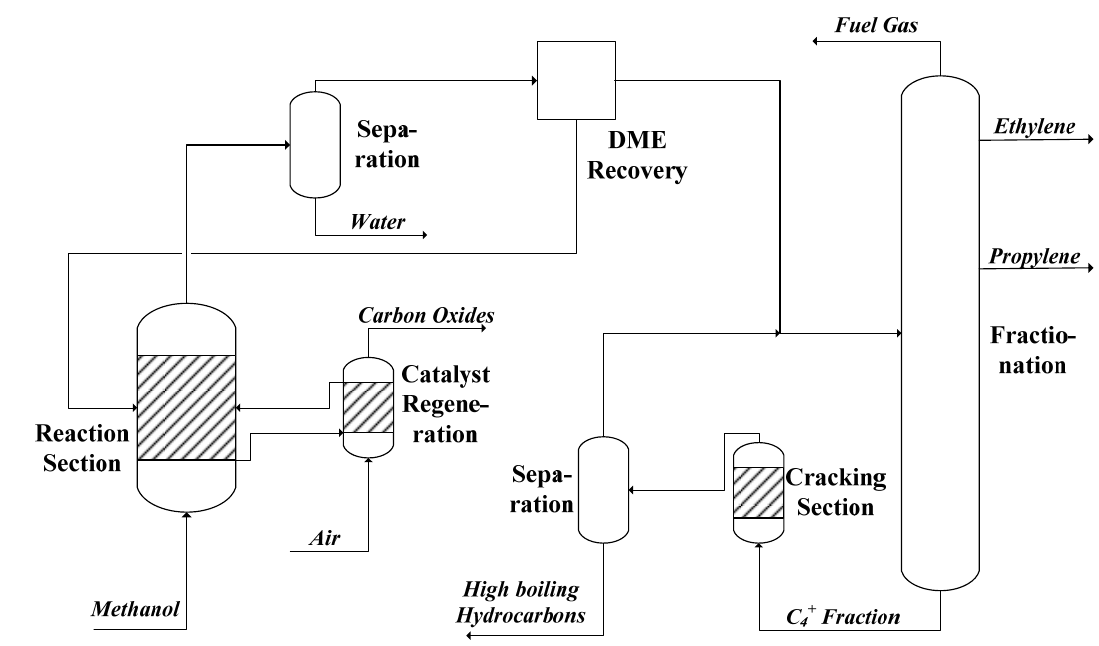
Figure 2. Process flow diagram methanol-to-olefins process